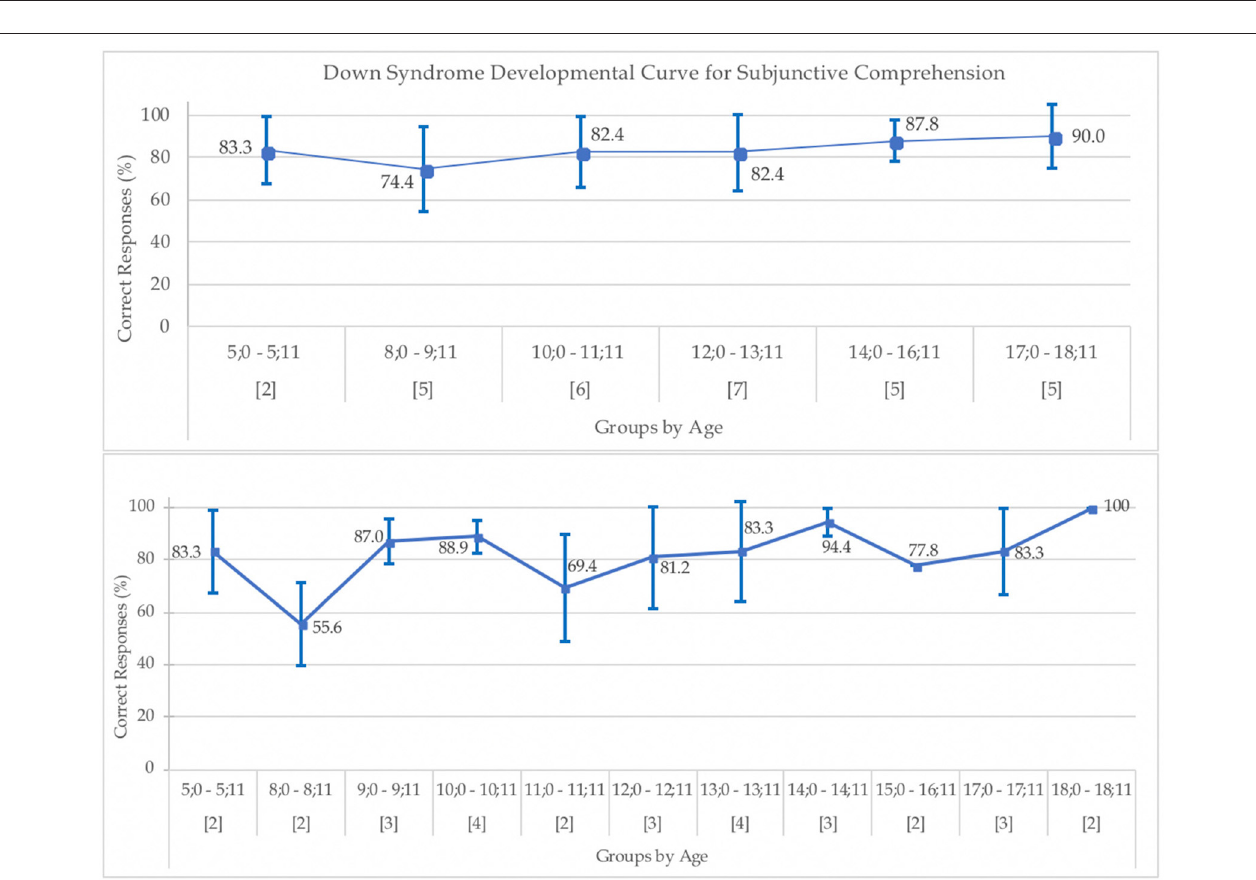
FIGURE 4 | Developmental Trajectory of the comprehension of subjunctive clauses in DS. In each graph, the (Top) of each figure shows a broader breakdown of each group by age, while the (Bottom) shows a more detailed breakdown of each group by age. The number of participants per group/age is noted in square brackets [ ] underneath each age range. Each data point represents the mean percentage of the participants’ means whose age falls within each respective age range. For example, in the top panel of this figure, 83.3% is the average of the combined means for the two participants in that age group (72.22% and 94.44%).